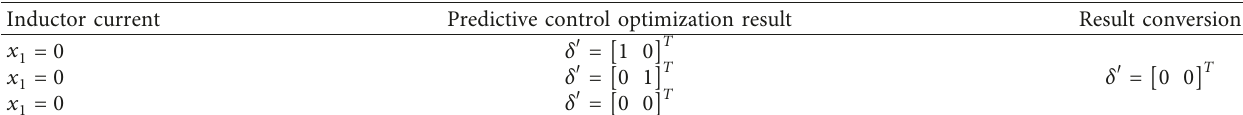
Table 2: Optimization result conversion of the model predictive control.